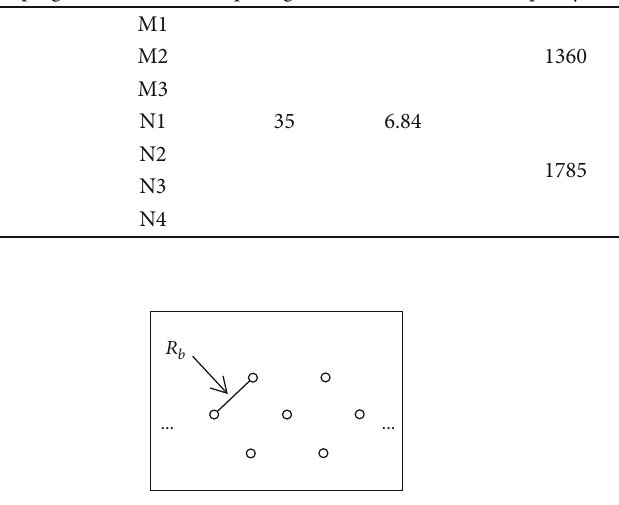
Figure 9: Recommended layouts of multiple in fl atable